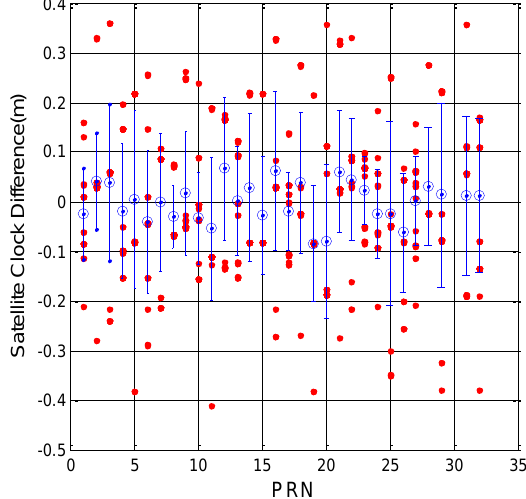
Figure 8. GPS DQA2: Satellite clock correction difference between new and original ephemeris.